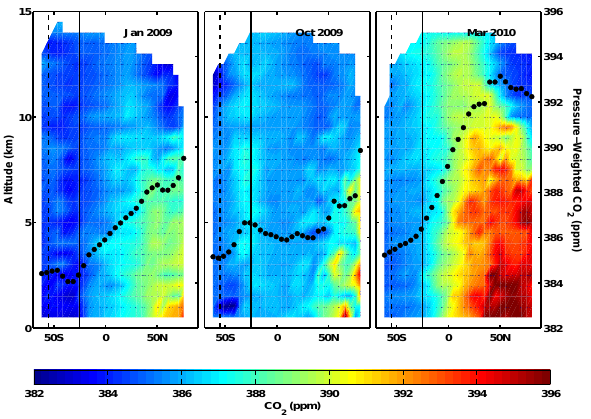
Fig. 3. The time series of the Southern Hemisphere TCCON data from Lauder, New Zealand and Wollongong, Australia are plot- ted in the top panel, along with the 1.89ppmyr − 1 secular increase (blue). The Baring Head GLOBALVIEW climatological seasonal cycle with a time lag of 6 weeks and a reduced amplitude ( × 0 . 65) is superimposed on the secular increase (red). In the bottom panel, the red curve is removed from the Lauder and Wollongong data to show the